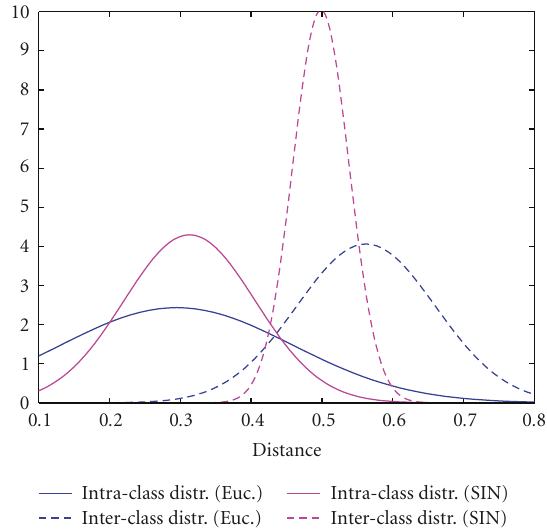
Figure 3: Comparison of intraclass and interclass distribution using Euclidean and SIN